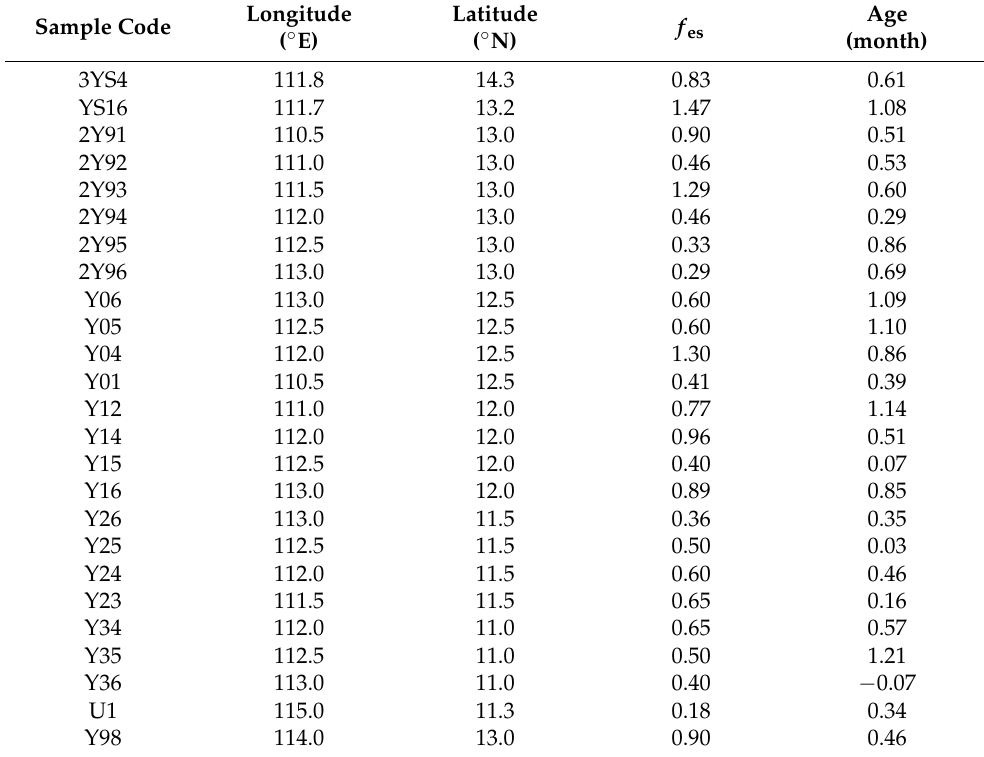
Table A1. The information of radium isotope sampling for the Mekong river plume group adapted with permission from ref. [9], Copyright 2010 American Geophysical Union.